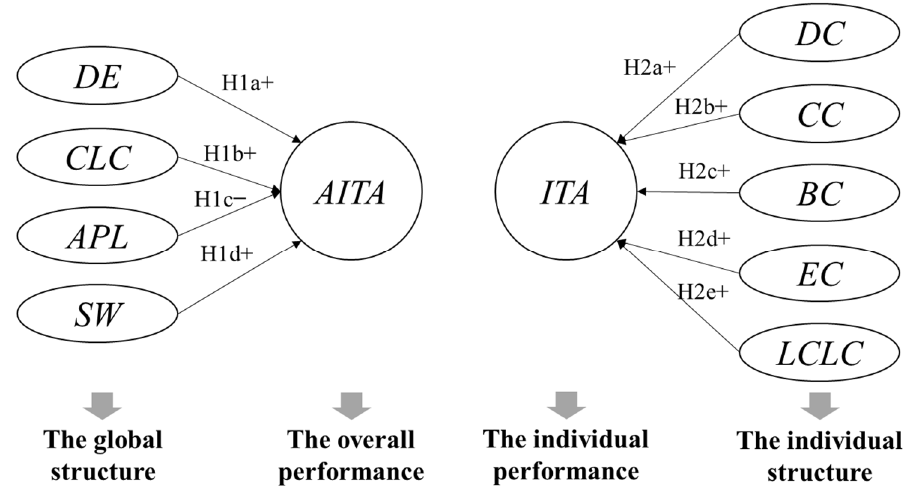
Figure 2. The hypotheses model.